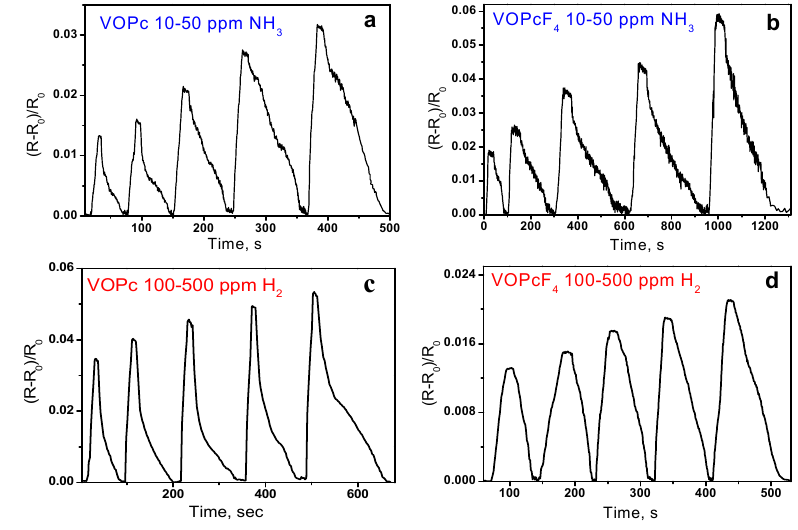
Figure 4. Sensor response of VOPc and VOPcF 4 films to ammonia ( a , b ) and hydrogen ( c , d ).